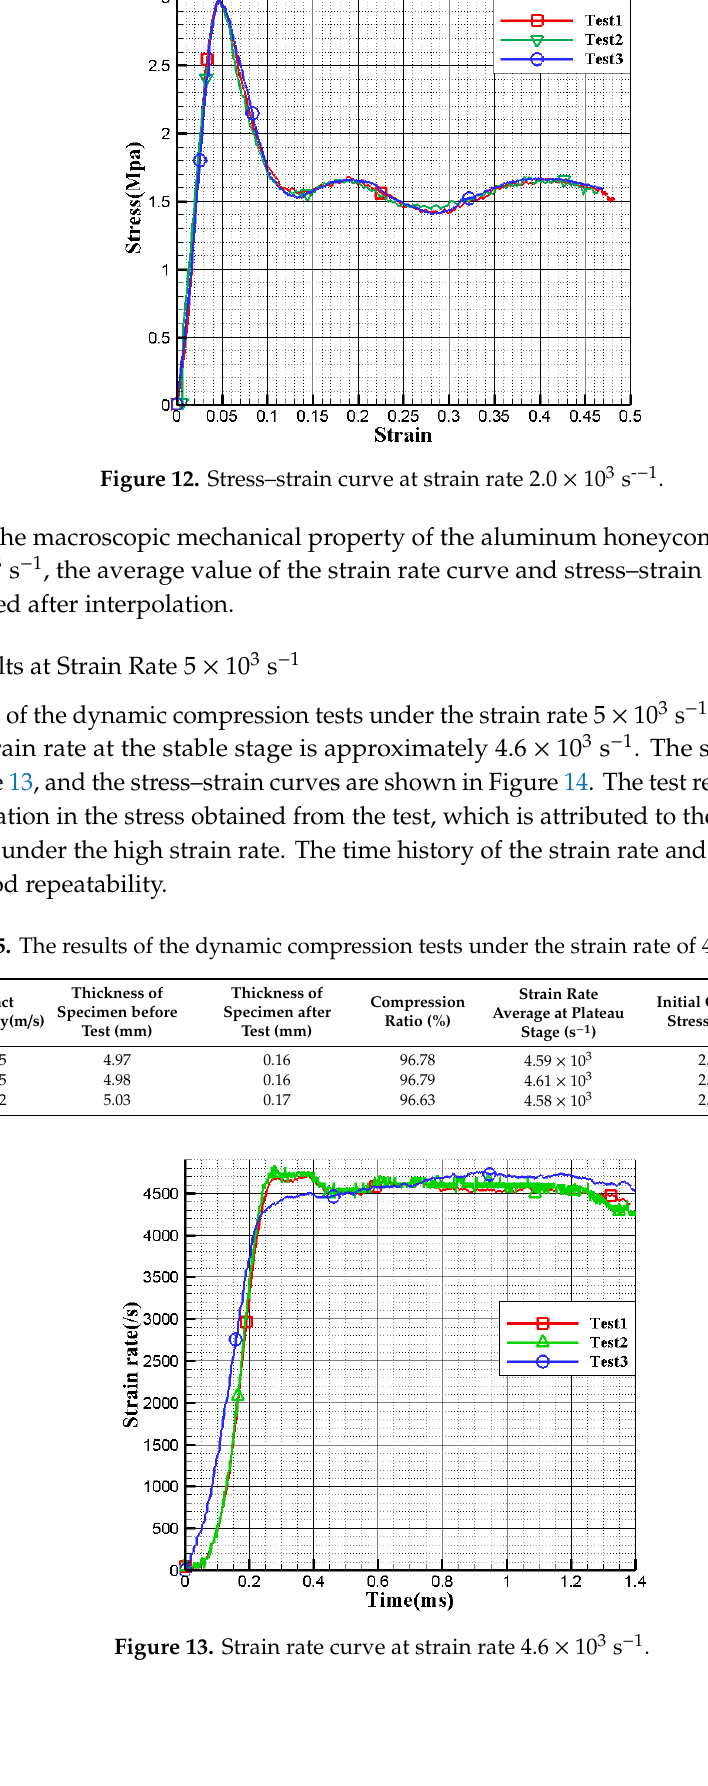
Figure 11. Strain rate curve at strain rate 2.0 × 10 3 s − 1.